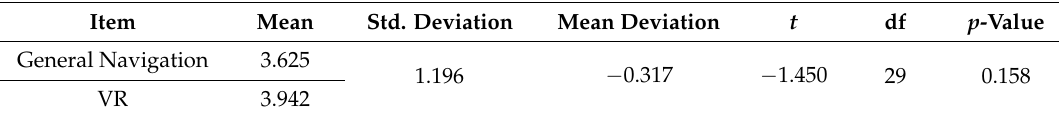
Table 2. Hypothesis test of perceptive ease of use.